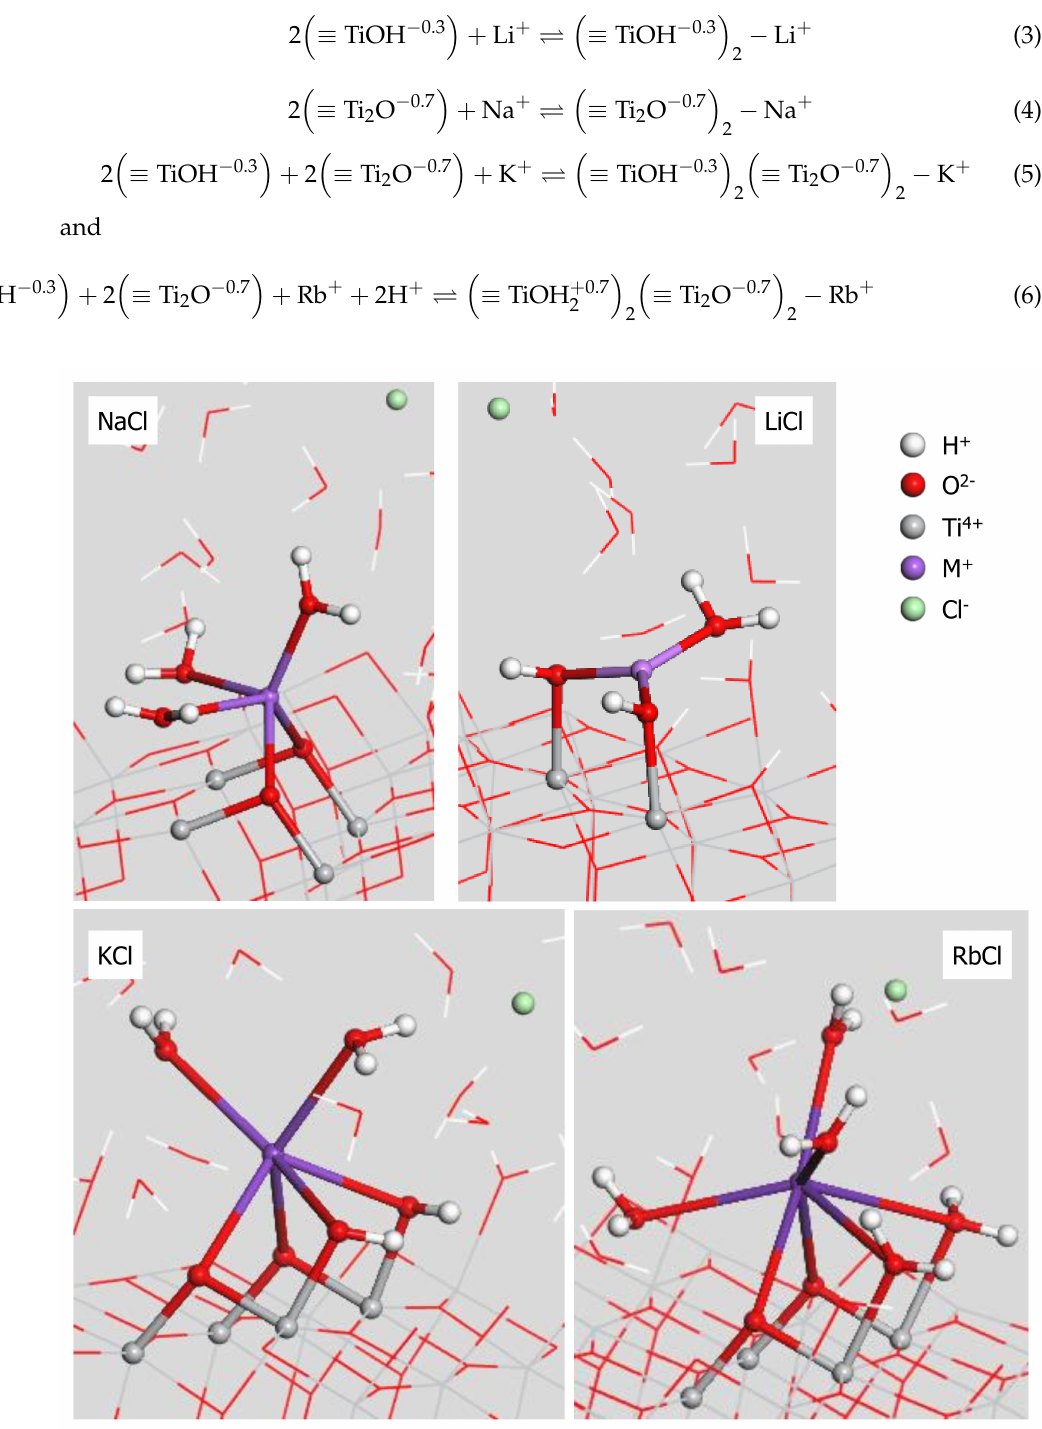
Figure 4. Schematics of the anatase (101) surface plane and representative coordination geometries for the inner-sphere (purple, M + ) bidentate Na + and Li + ions, tetradentate K + and Rb + ions, and outer-sphere (green) Cl – ion, from the MD-DFT